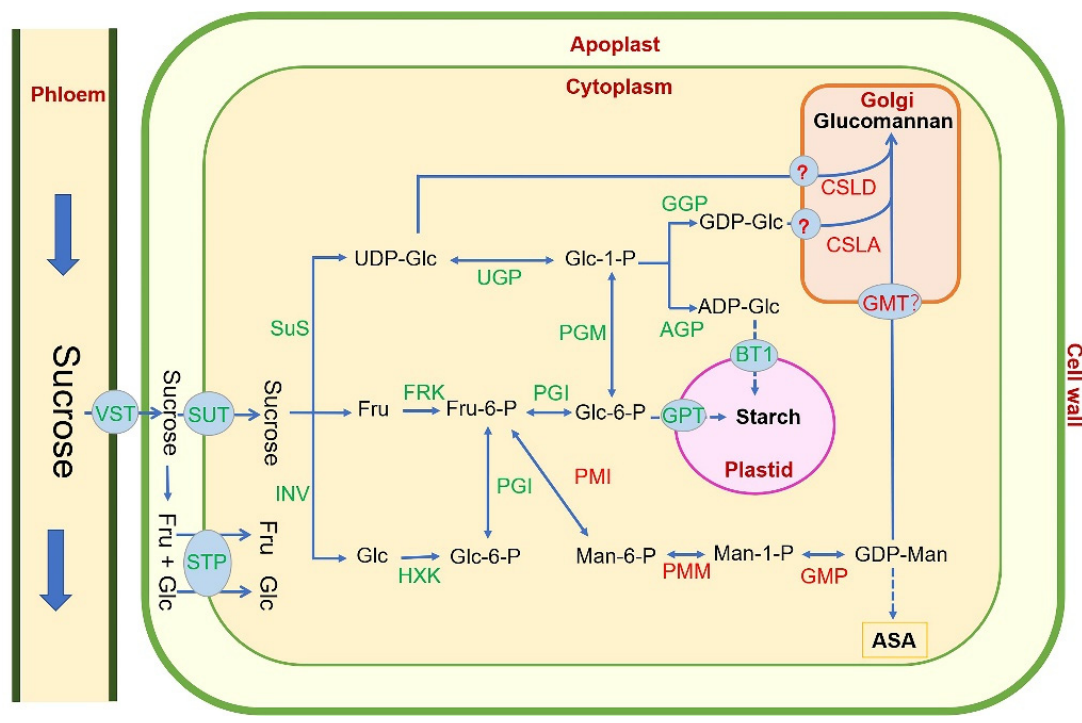
Figure 4. Putative glucomannan biosynthetic pathway in D. catenatum (modified from [41,44,45,88] Glc, glucose; Fru, fructose; Fru-6-P, fructose-6-phosphate; Glc-1-P, glucosophosphate-1-P; Glc-6-P, glucosophosphate-6-P; Man, mannose; Man-6-P, mannose-6-phosphate; Man-1-P, mannose-1-